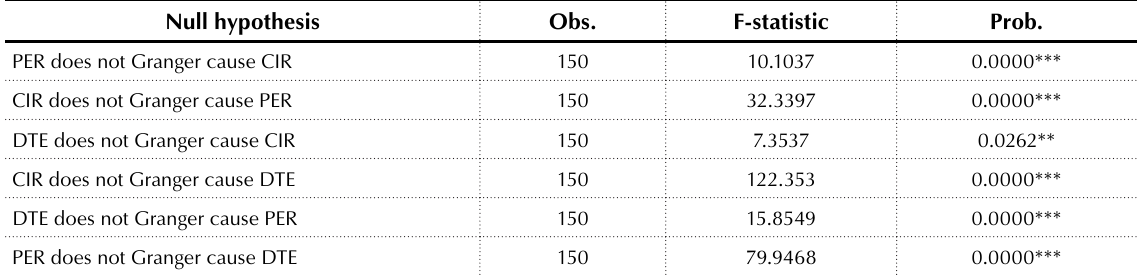
Source: researcher’s computation